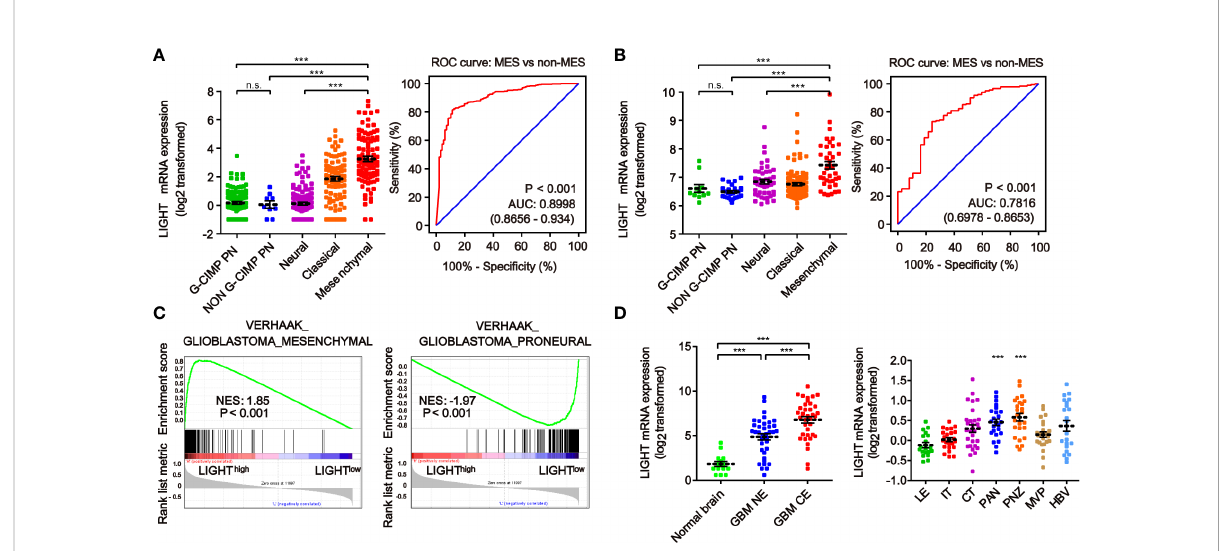
FIGURE 2 The heterogeneity of LIGHT expression within and between gliomas. The expression level of LIGHT mRNA in gliomas classi fi ed by the VERHAAK_2010 molecular classi fi cation, including CpG island methylator phenotype (G-CIMP) proneural, non-G-CIMP proneural, neural, classical, and mesenchymal subtypes, in the TCGA (A) and CGGA (B) databases. The corresponding ROC curves indicated that LIGHT is a diagnostic marker of the mesenchymal subtype. (C) GSEA enrichment of MES and PN signatures analyzing LIGHThigh vs LIGHTlow samples in the TCGA dataset of GBM. The normalized enrichment score (NES) and FDR are noted in the fi gure. (D) The analysis of LIGHT mRNA levels with the Gill dataset (n = 75) in different radiographical regions of GBM, including normal brain, T1 contrast-enhancing (CE) area and non-enhancing (NE; abnormal T2/FLAIR signal) area. (E) The analysis of LIGHT mRNA levels with IVY GBM RNA-seq data (n = 270) of different anatomical regions, including LE (Leading Edge), IT (In fi ltrating Tumor), CT (Cellular Tumor), PAN (Pseudopalisading Cells Around Necrosis), PNZ (Perinecrotic Zone), MVP (Microvascular Proliferation), and HBV (Hyperplastic Blood Vessels). ns P >0.05; ***P <